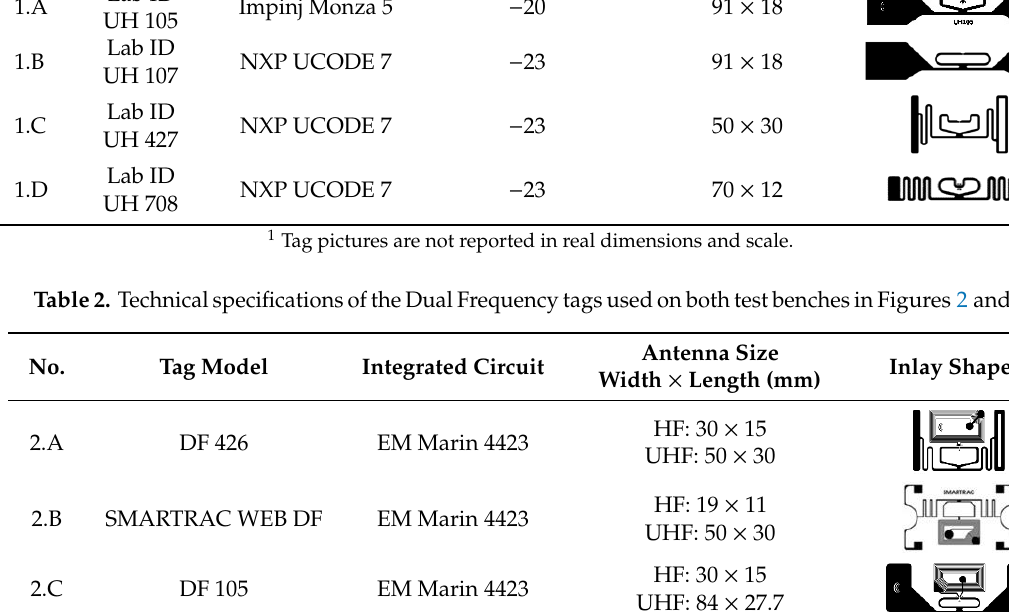
Table 1. Technical specifications of the Ultra-High Frequency tags used on the test bench in Figure 2.